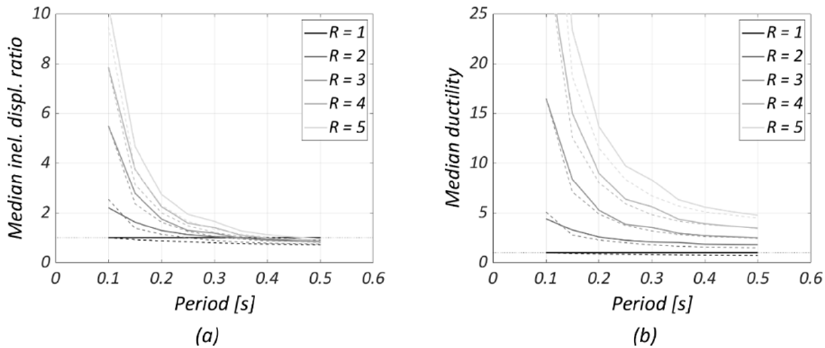
Figure 13. Comparison between the predictions by the proposed OSM (solid lines) and the results from NLTHA of Suite 2-A (dashed lines): ( a ) median C R − R − T curves, and ( b ) median µ R − R − T curves. Table 1. Calibrated parameters for the proposed OSM equations.